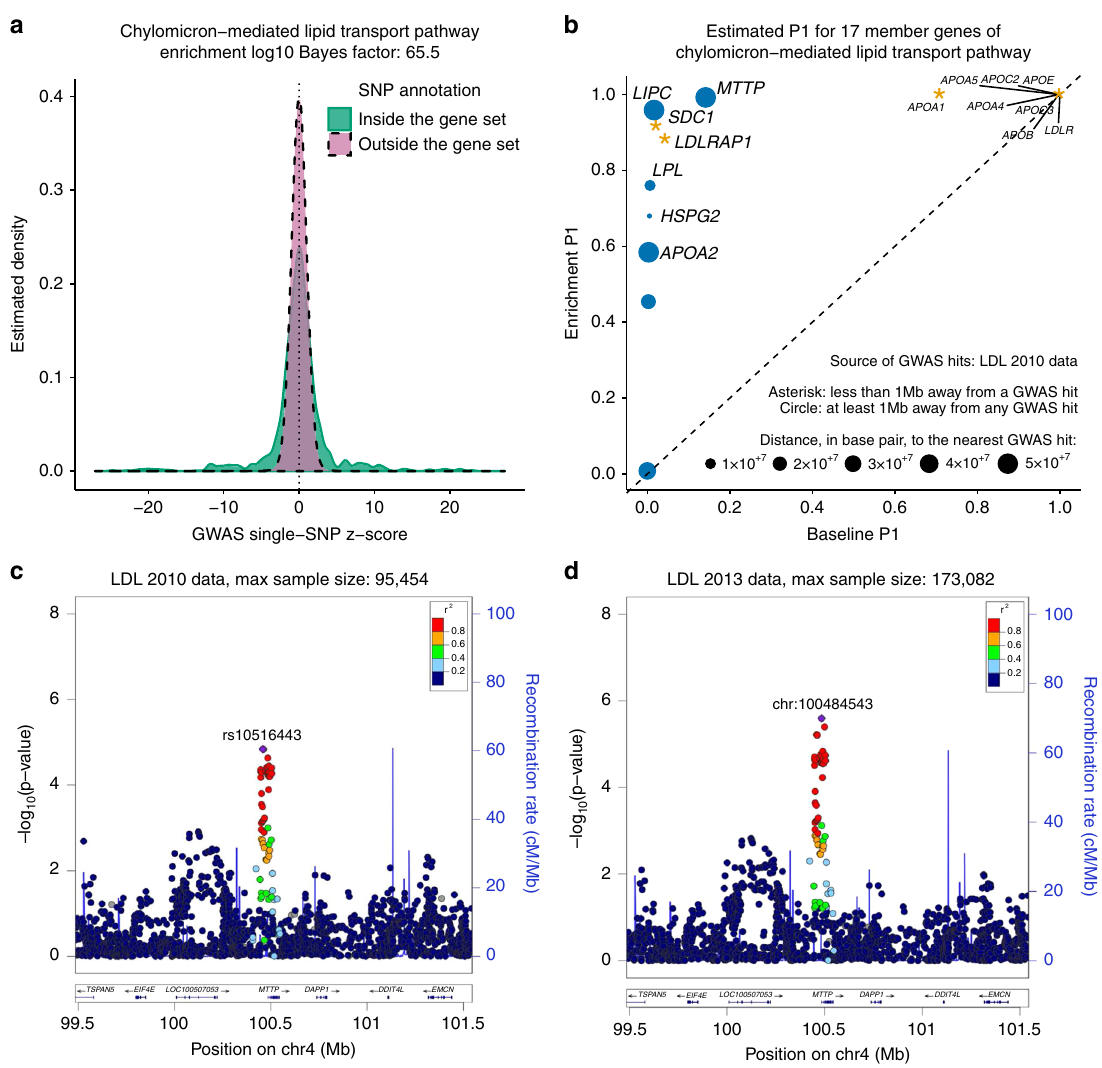
Fig. 5 Enrichment of chylomicron-mediated lipid transport pathway informs a strong association between a member gene MTTP and levels of low-density lipoprotein (LDL) cholesterol. a Distribution of GWAS single-SNP z -scores from summary data published in 2010 41 , strati fi ed by gene set annotations. The solid green curve is estimated from z -scores of SNPs within 100 kb of the transcribed region of genes in the chylomicron-mediated lipid transport pathway ( “ inside ” ), and the dashed reddish purple curve is estimated from z -scores of remaining SNPs ( “ outside ” ). This panel serves as a visual sanity check to con fi rm the observed enrichment. b Estimated posterior probability ( P 1 ) that there is at least one associated SNP within 100 kb of the transcribed region of each pathway-member gene under the enrichment model ( M 1 ) versus estimated P 1 under the baseline model ( M 0 ). These gene-level P 1 estimates and corresponding SNP-level statistics are provided in Supplementary Table 4. Yellow asterisks denote genes that are less than 1 Mb away from a GWAS hit. Blue circles denote genes that are at least 1 Mb away from any GWAS hit. c Regional association plot for MTTP based on summary data published in 2010 41 . d Regional association plot for MTTP based on summary data published in 2013